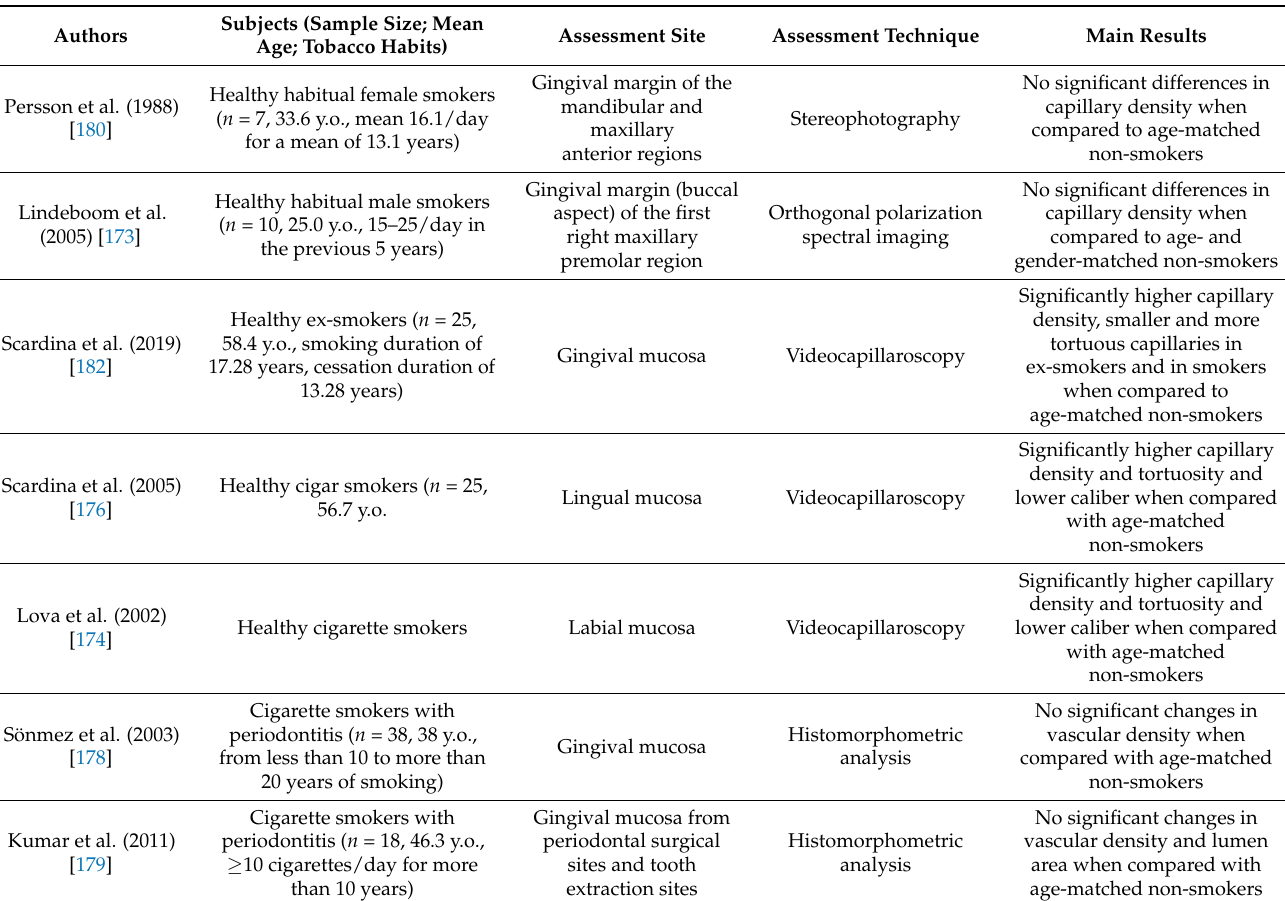
Table 3. Description of the main results of the most relevant studies into the effect of tobacco products on the oral microvascular morphology in vivo (y.o.—years